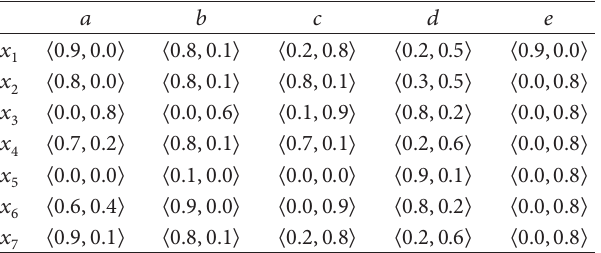
Table 3: The target IF formal context 𝐾